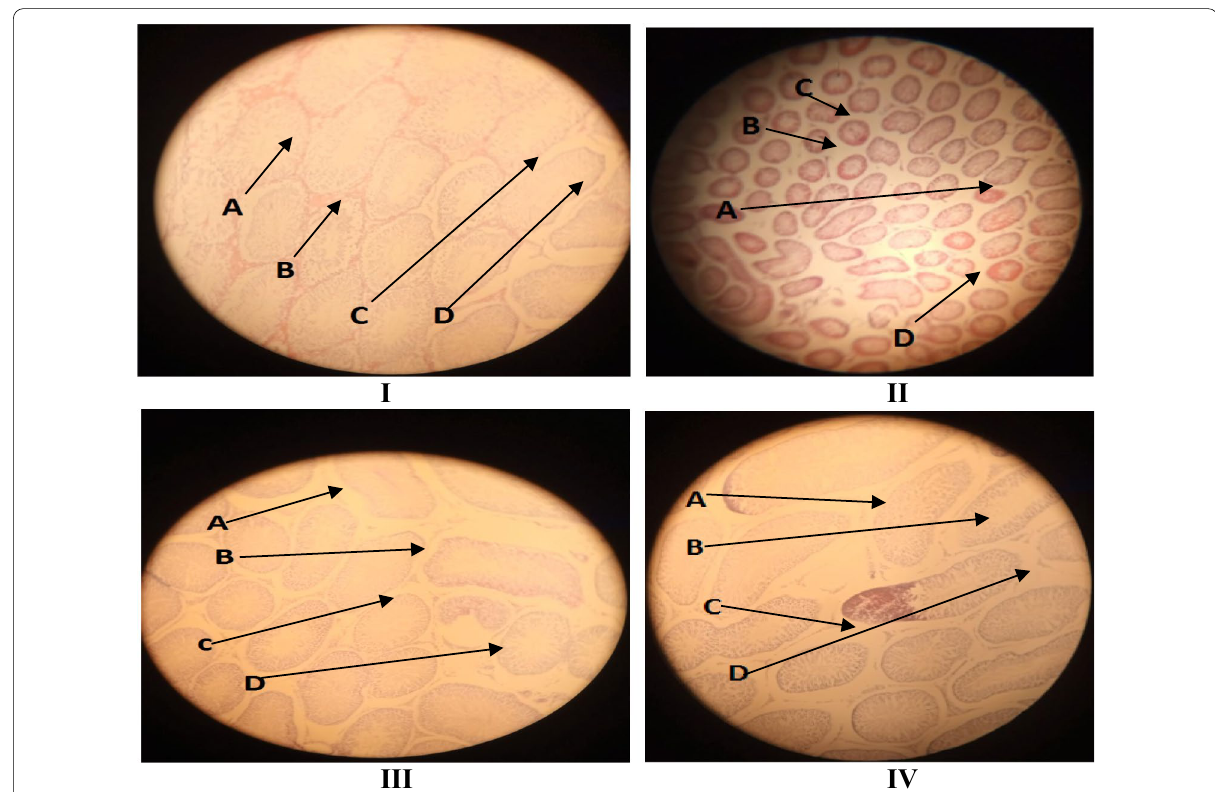
Fig. 1 Photomicrograph of the testes (Mag kg Cissus populnea suspension, III